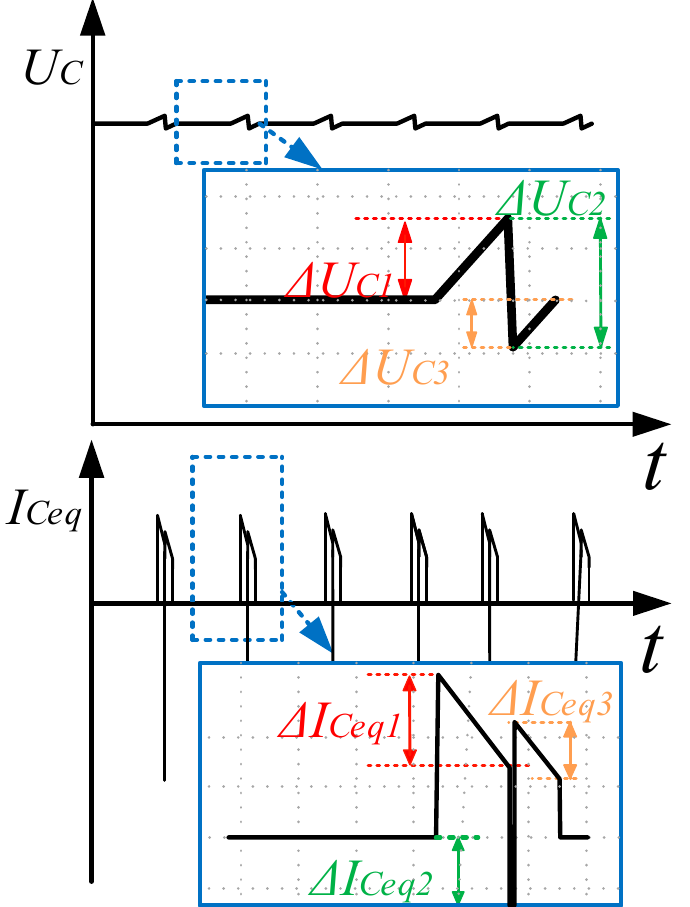
Figure 6. Waveform of capacitor current and voltage.